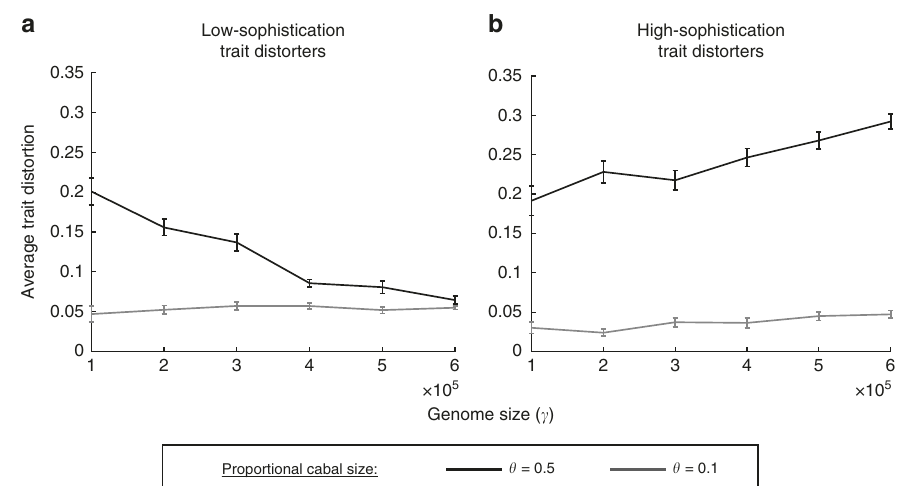
Fig. 5 Effect of genome size ( γ ) on average trait distortion when trait distorters can co-segregate. The average trait distortion is plotted against genome size ( γ ), for two different proportional cabal sizes (black: θ = 0.5; grey: θ = 0.1). a shows low-sophistication trait distorters ( D 1L ), which are partially suppressed by non-dedicated suppressors (background or generalist suppression), and incur a high cost even when inter-locus recessive. b shows high sophistication distorters ( D 1H ), which are only suppressed by dedicated suppressors, and incur a low cost when inter-locus recessive. The results plotted are an average of 36 runs of our agent-based simulation (error bars represent 1 standard error in each direction), each over T end = 30,000 generations, where trait distorters and their dedicated suppressors are introduced stochastically. When proportional cabal size ( θ ) is smaller, the level of trait distortion is small, and genome size has little in fl uence. When proportional cabal size ( θ ) is larger, the trait distortion is larger and depends upon genome size. Low- sophistication trait distorters interact counter-productively when co-segregating, meaning trait distortion decreases with genome size, while high- sophistication trait distorters interact productively when co-segregating, meaning trait distortion increases with genome size ( c sup = 0.01, t = k , c trait =